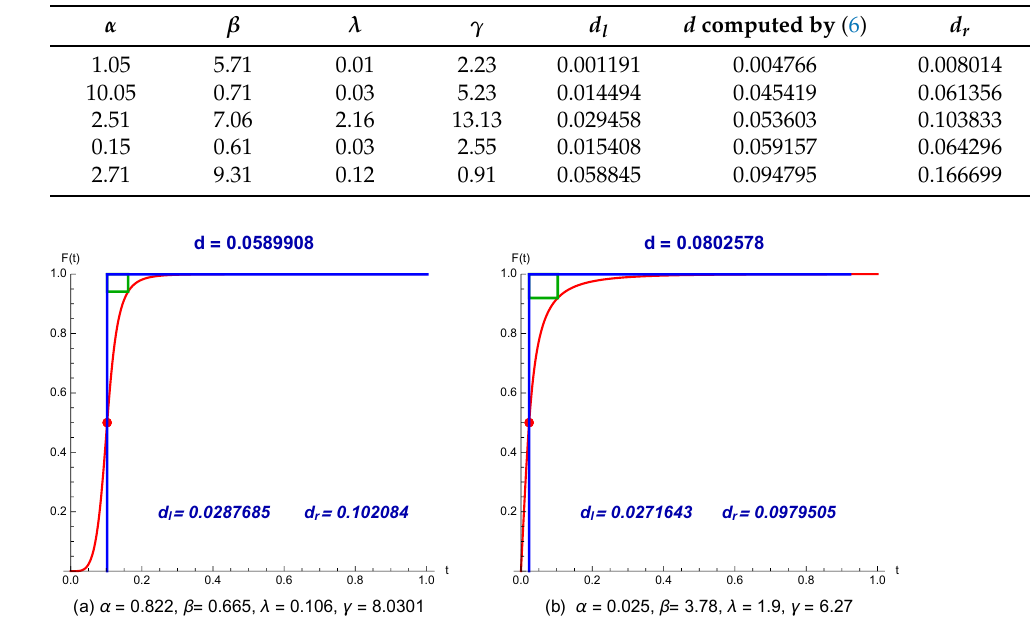
Figure 2. Approximation of CDF function of GOPC-LL